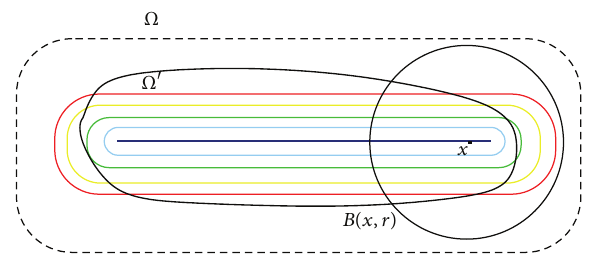
Figure4:ThelevelsetsofafunctionthatisVodopyhanov-Goldstein monotone but not Lebesgue